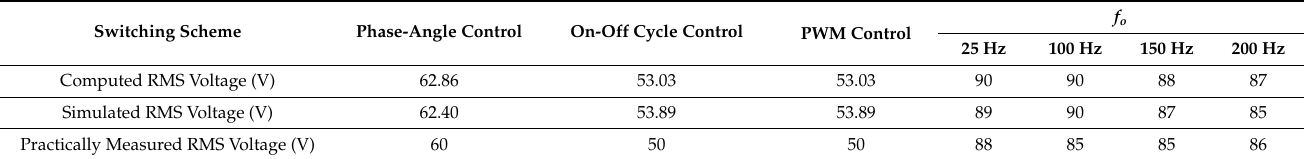
Table 9. RMS values of the voltage fundamental components for various switching